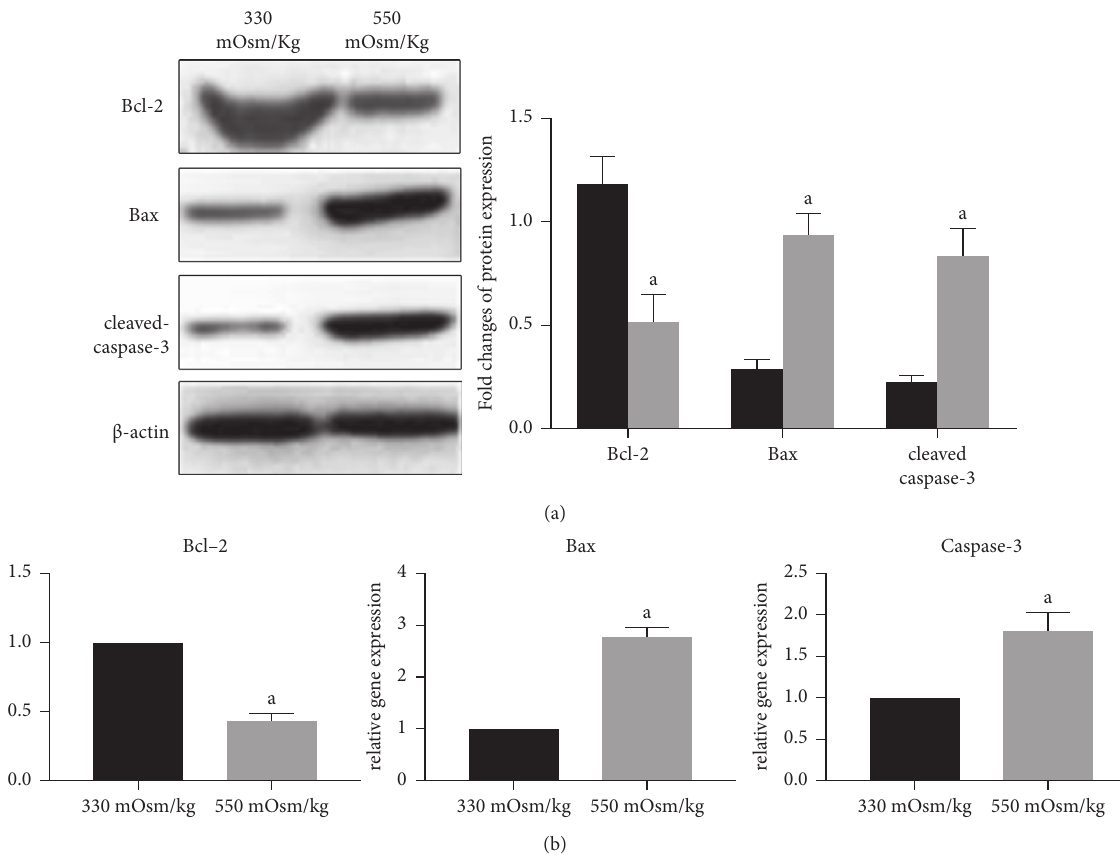
Figure 2: Hyperosmolarity increased the expression of proapoptosis molecules (Bax and caspase-3/cleaved caspase-3) and decreased the expression of antiapoptosis molecules (Bcl-2). (a,b) Real-time PCR and western blotting analysis of proapoptosis (Bax and caspase-3/cleaved caspase-3) and antiapoptosis (Bcl-2) molecules under different osmotic pressures (330 mOsm/kg and 550mOsm/kg), respectively. Data are expressed as mean ± SD. (A) indicates a significant difference ( p < 0 . 05) when compared with